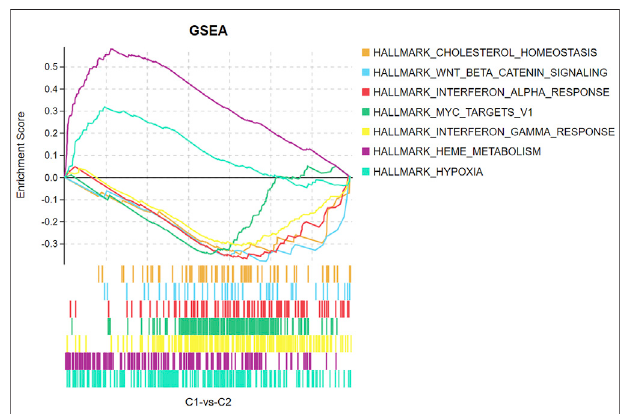
FIGURE7| GSEAenrichmentanalysisshowingfunctionalenrichment in the C1 and C2 groups.